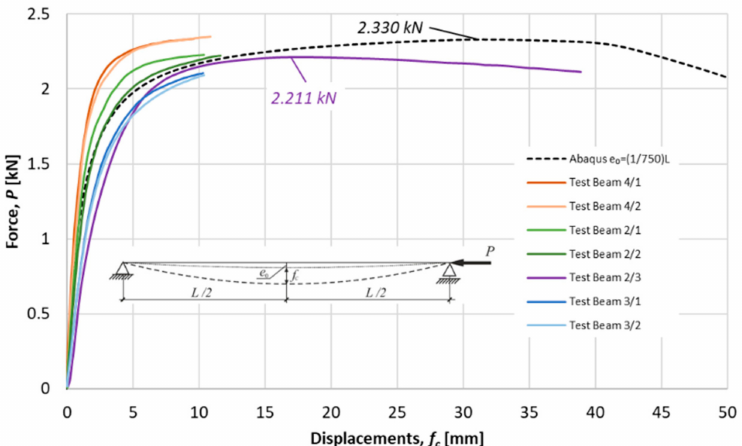
Figure 15. Specimen L = 915.1 mm. Load deflection paths obtained in experimental tests and numerically.